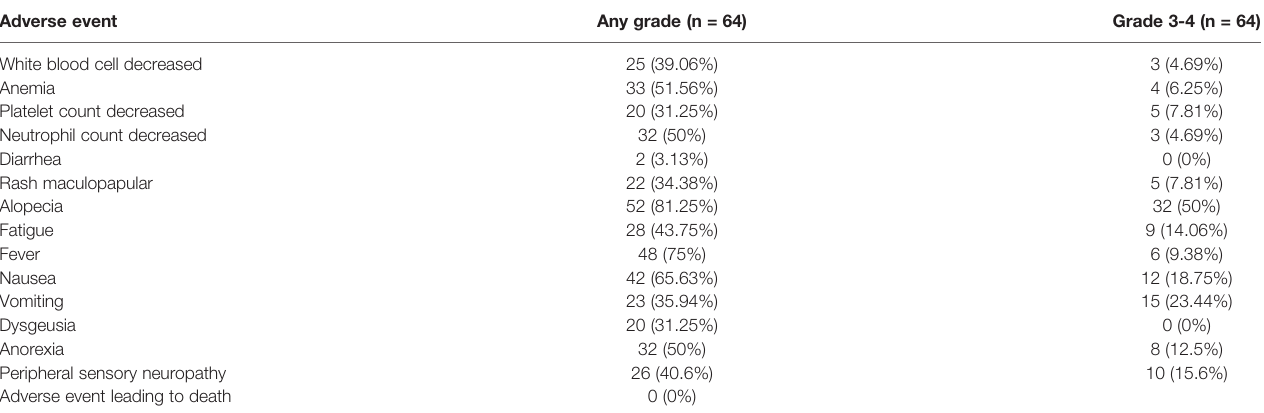
TABLE 3 | Summary of adverse